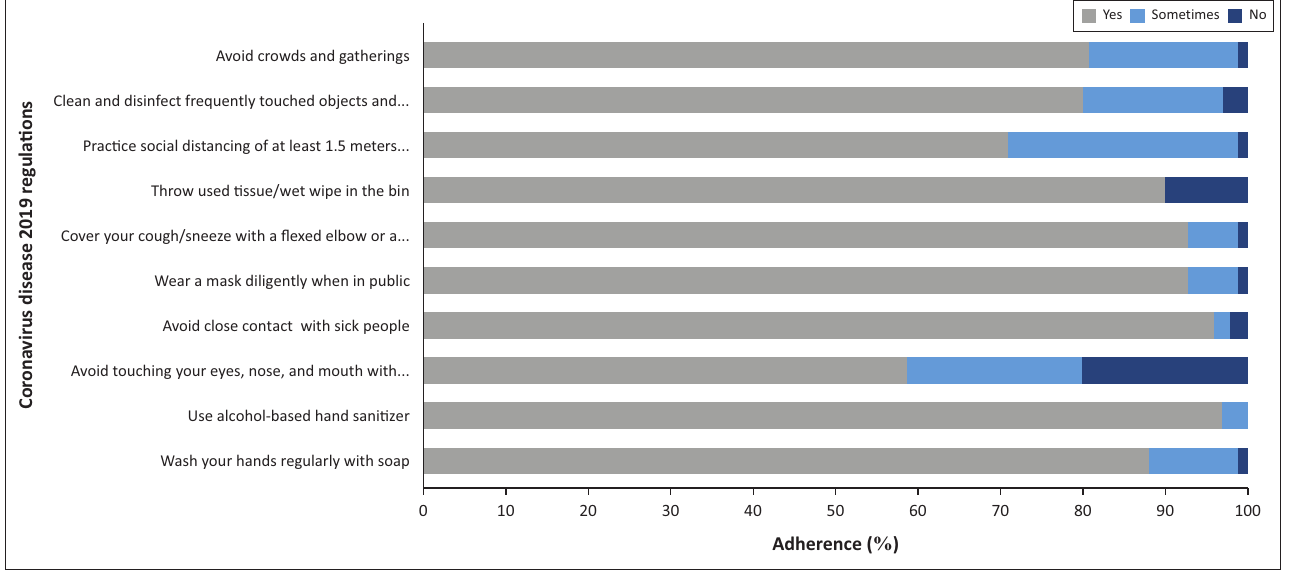
FIGURE 2: Coronavirus disease 2019 regulations adherence.